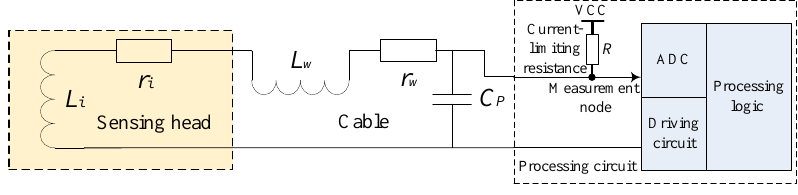
Figure 2. The equivalent circuit of the